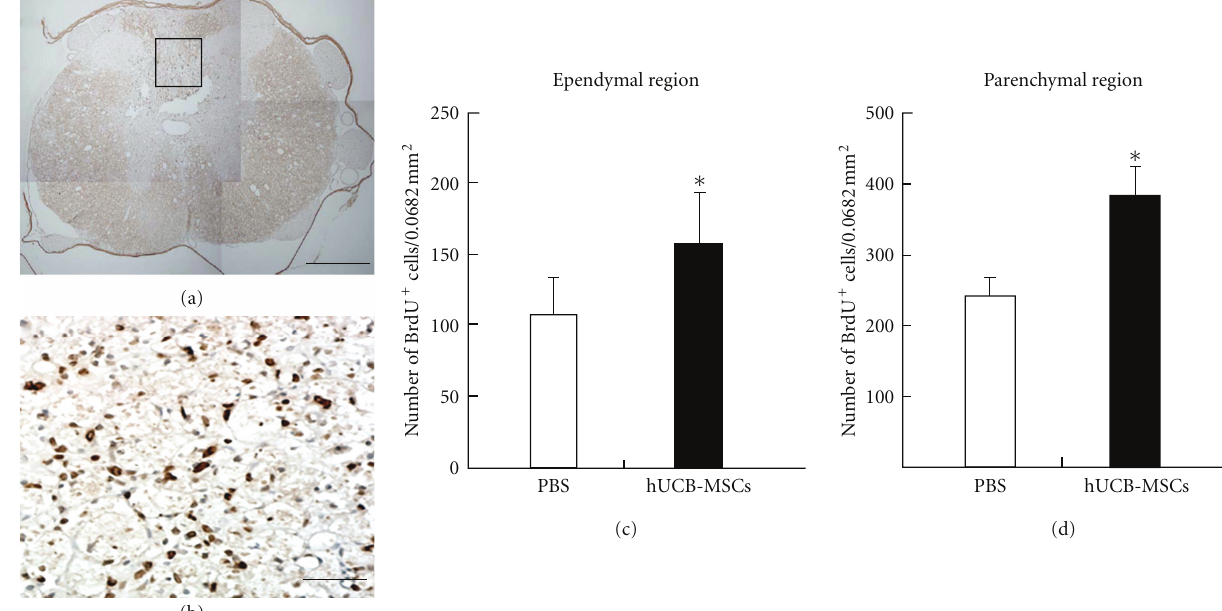
Figure 2: Quantitative analysis of BrdU-labeled cells in the ependymal and parenchymal regions. (a) Result of immunohistochemistry using anti-BrdU antibody. (b) Enlargement of the boxed region in (a), showing BrdU-labeled cells in the parenchymal region. (c) Average number of BrdU-labeled cells per white matter area from all five white matter areas in the parenchymal region. (d) Average number of BrdU-labeled cells per ependymal region in grey matter. At 14 days after transplantation, proliferation of endogenous cells was significantly increased from injury site to cell transplantation site in hUCB-MSCs-transplanted group compared with control group, ∗ P < 0 .